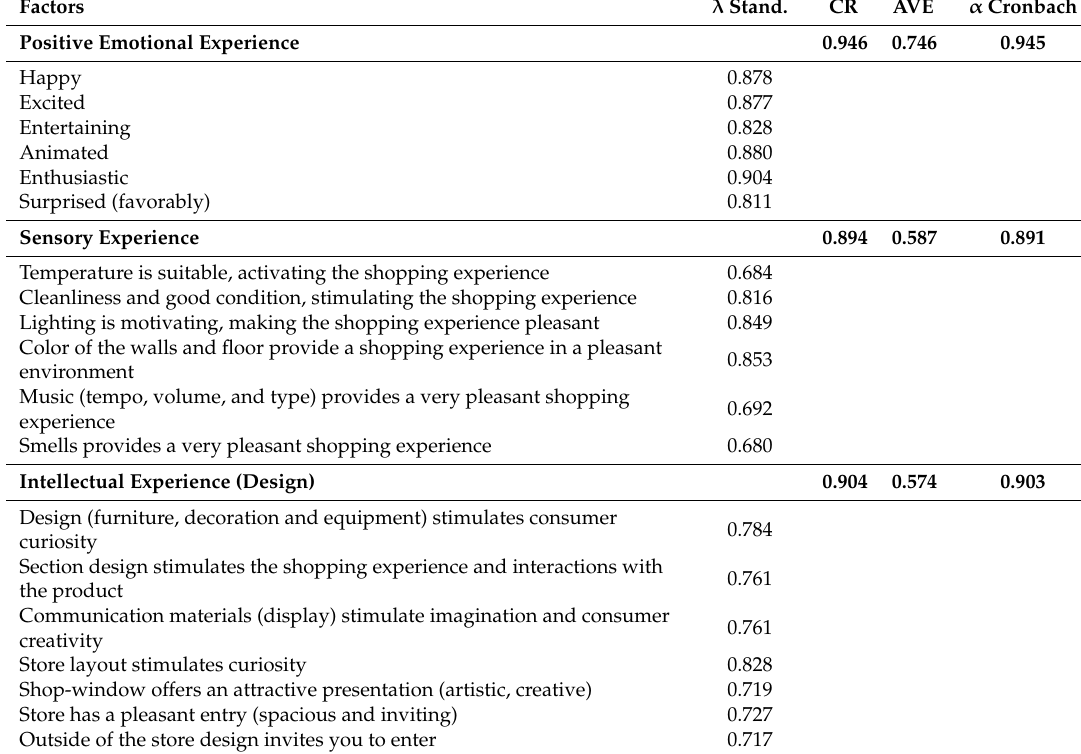
Table 3. Analysis of the reliability and validity of the proposed